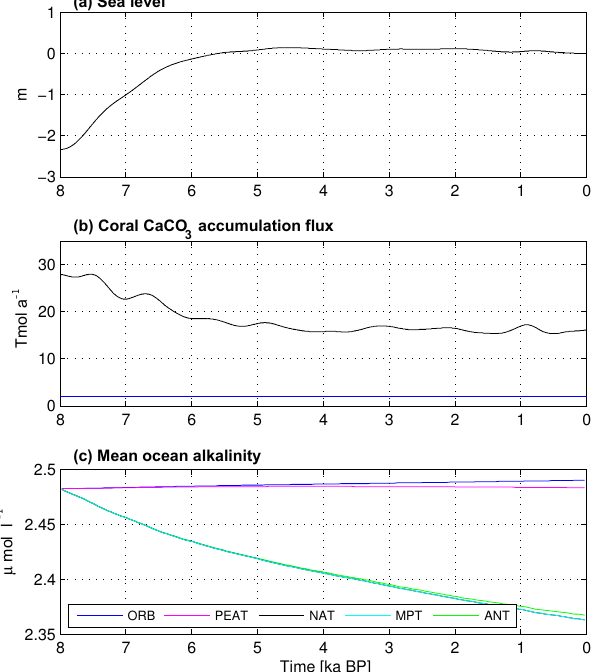
Figure 5. Sea level forcing (a) , shallow-water CaCO 3 accumula- tion flux (b) and mean ocean alkalinity (c) in the Holocene experi- ments. Plots have been smoothed for